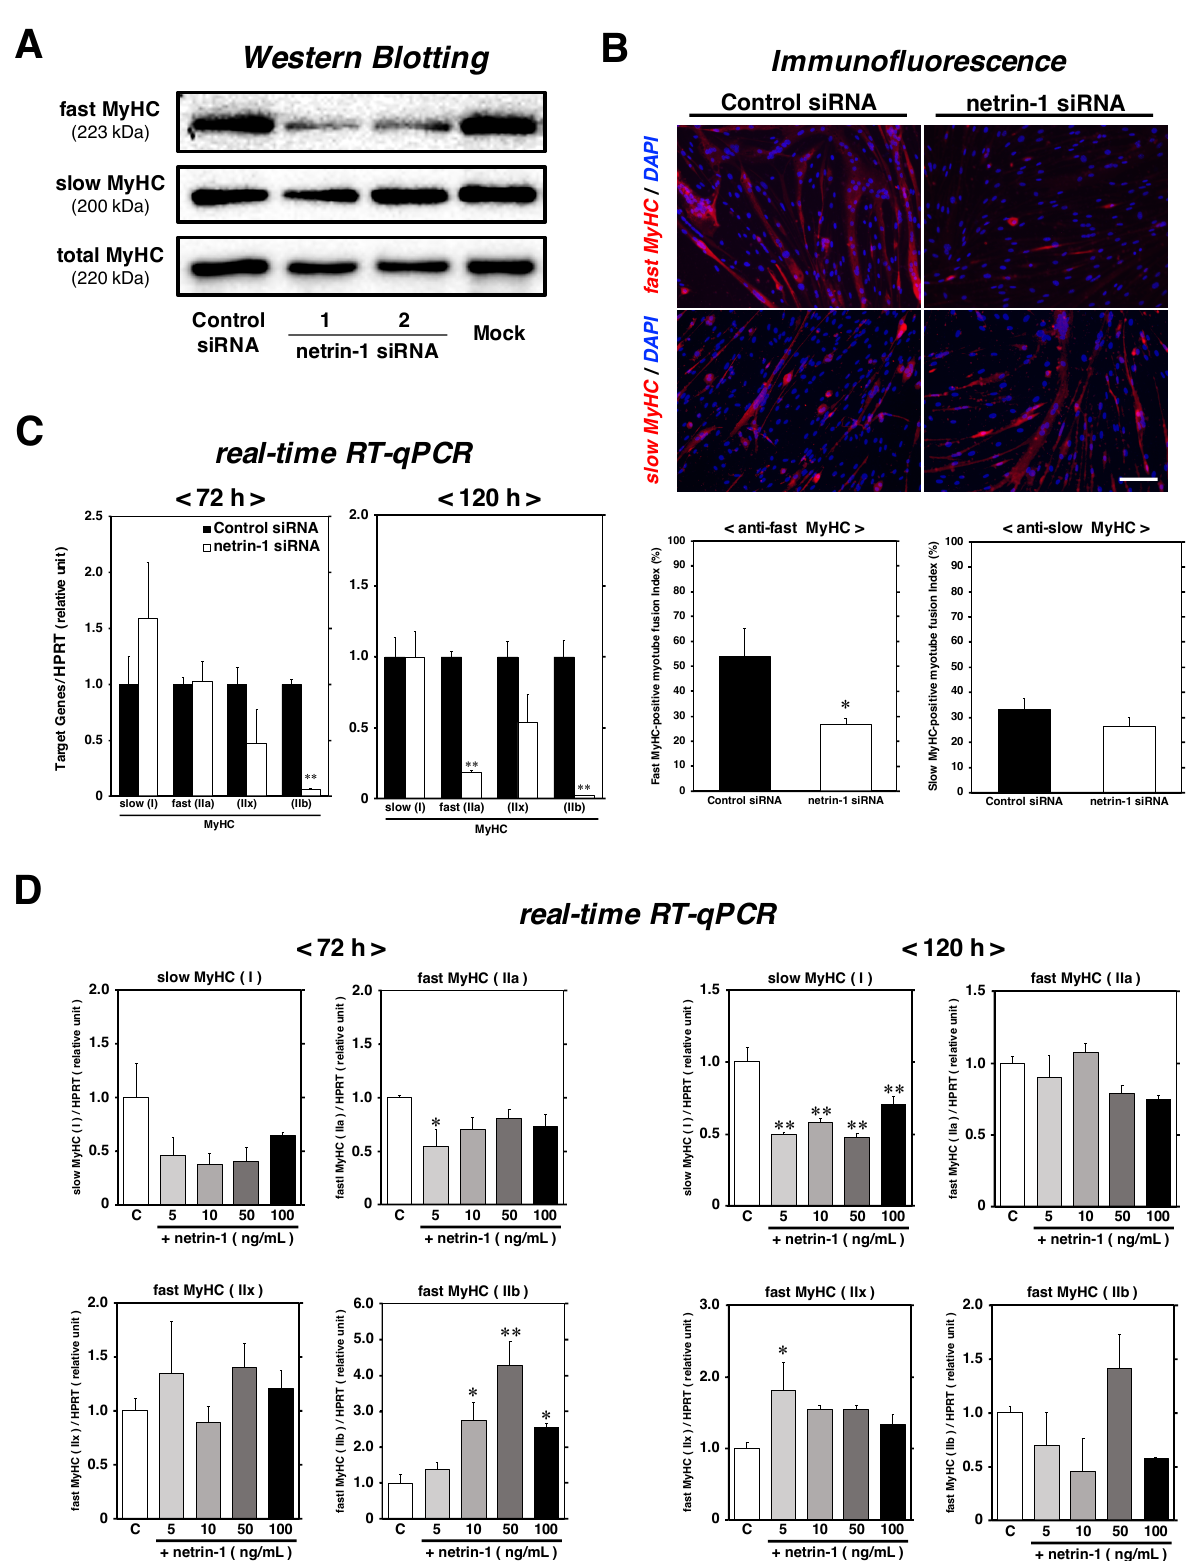
Figure 5. Significant reduction in the expression of fast-MyHC was observed following netrin-1 expression knockdown, and in the slow-MyHC expression level was found following netrin-1 addition to satellite cells. As described in Figure 4, proliferating satellite cell-derived myoblasts were maintained in DM with netrin-1 siRNA until 72 h or 120 h. (panel A ) The protein expression of fast MyHC (contained type IIa, IIx, and IIb) and slow MyHC (type I) was detected with Western Blotting using cell lysates after normalization to the expression level of total MyHC. (panel B ) Immunofluorescence microscopy